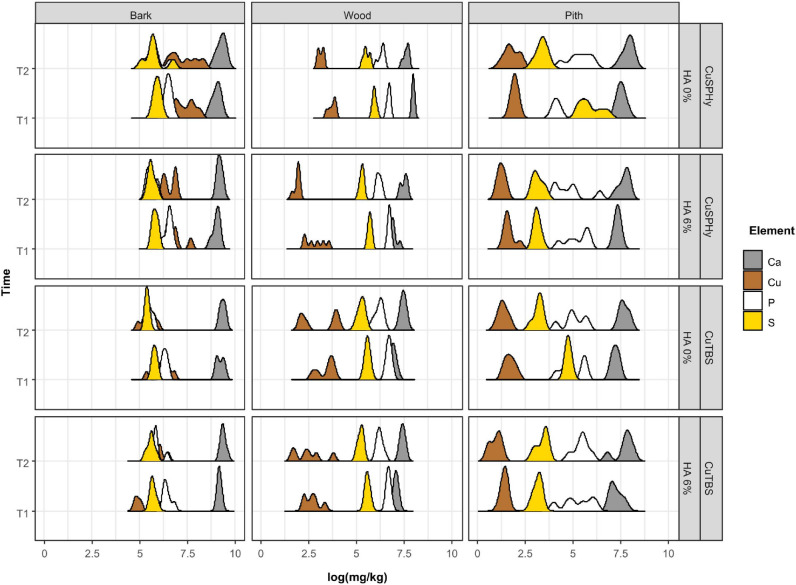
Data of the multi-elementary quantification (ICP-OES) have been logarithmically transformed to present all the elements regardless of the order of magnitude. The ridge plot shows how the abundance (mg/kg) of each element (Ca, Cu, P, and S) changes (x-axis) in different plant tissues (bark, wood, and pith) of six technical replicates, when different Cu formulations (CuSPHy and CuTBS) were applied alone or in combination with hydroxyapatite (HA 0%, HA 3%). Changes in element abundances were also monitored at two different time points (T1, T2), as reported in the y-axis. The ridge curves were plotted using ggridges and ggplot2 R packages. Differences in element abundances at each factor and interaction of factors were investigated with PERMANOVA (Supplementary Table 4).